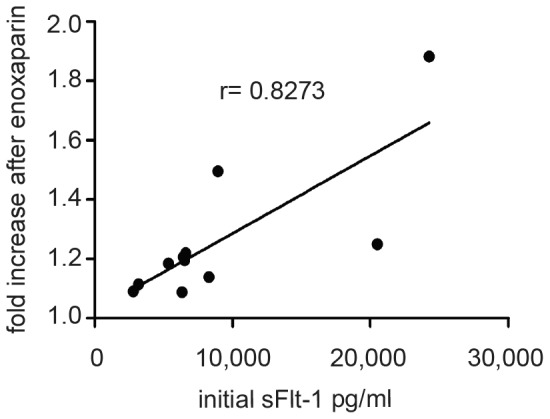
The rate of increase in serum sFlt-1 shows positive correlation with the initial serum sFlt-1 levels.Regression analysis of the alteration in serum sFlt-1 levels following enoxaparin (fold change) and initial sFlt-1 serum levels yields positive correlation with the Spearman correlation coefficient r = 0.8273 (95%CI = 0.4348 to 0.9556; p = 0.0014).